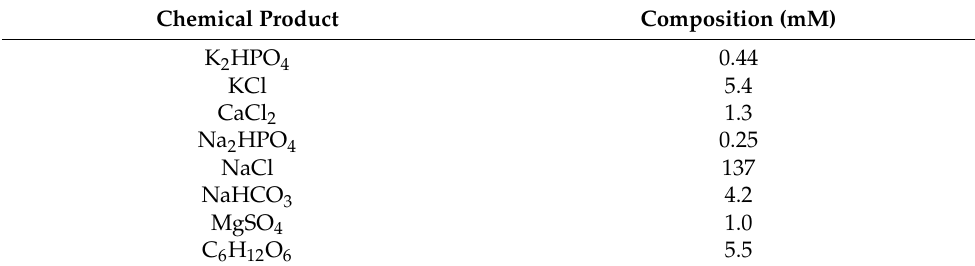
Table 1. Composition of Hank’s solution.